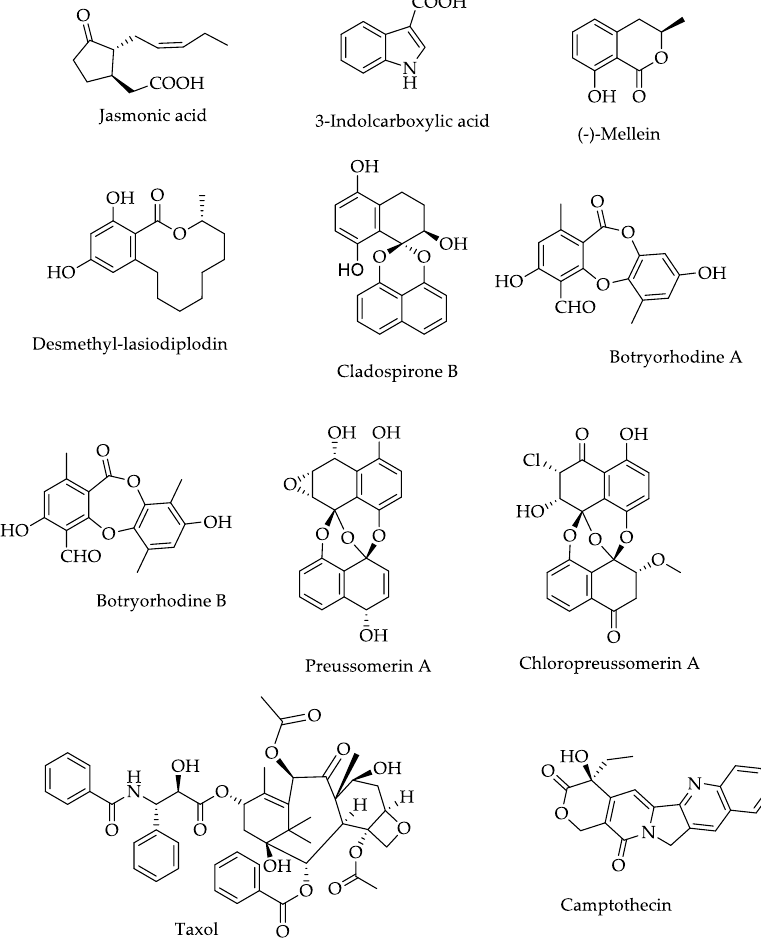
Figure 2. Representative secondary metabolites produced by endophytic Lasiodiplodia theobromae